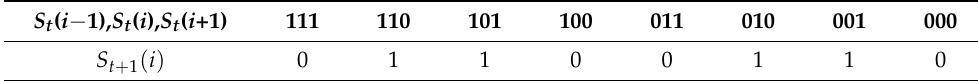
Table 1. The function f with a local transition rule r = 102.